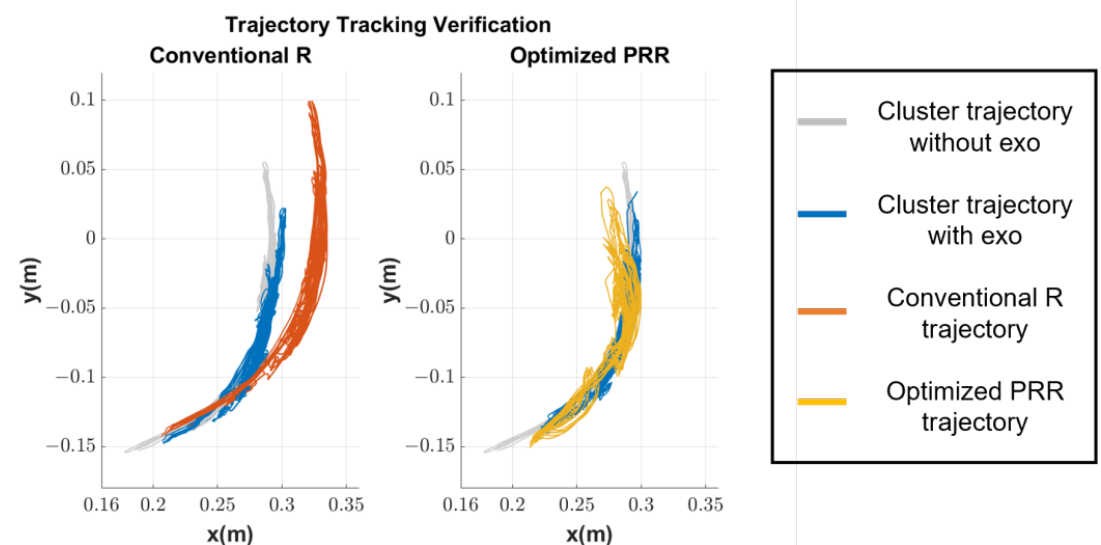
Table 3. Actual trajectory and orientation error during optimized motions.